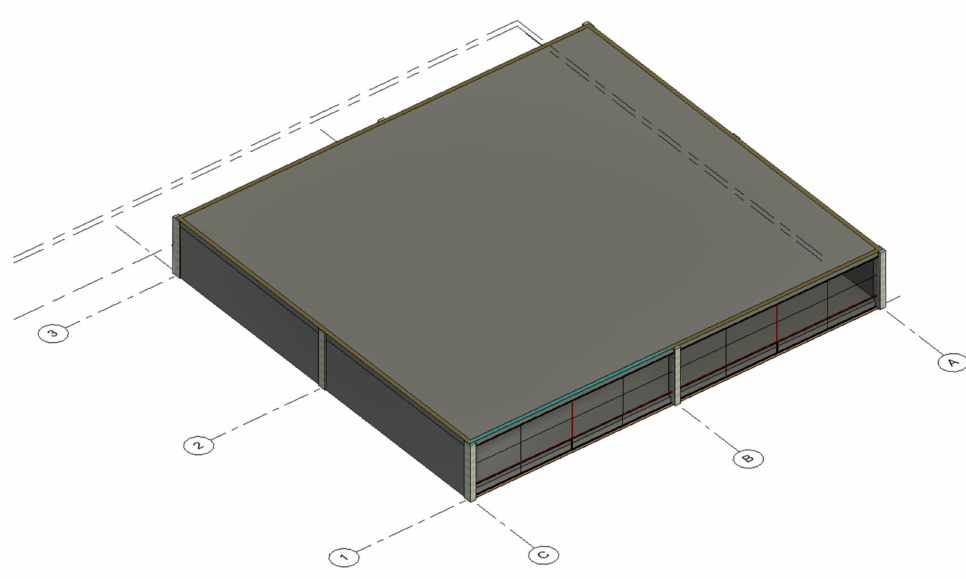
Figure A3. Case Study—Rectangle shape BIM model.